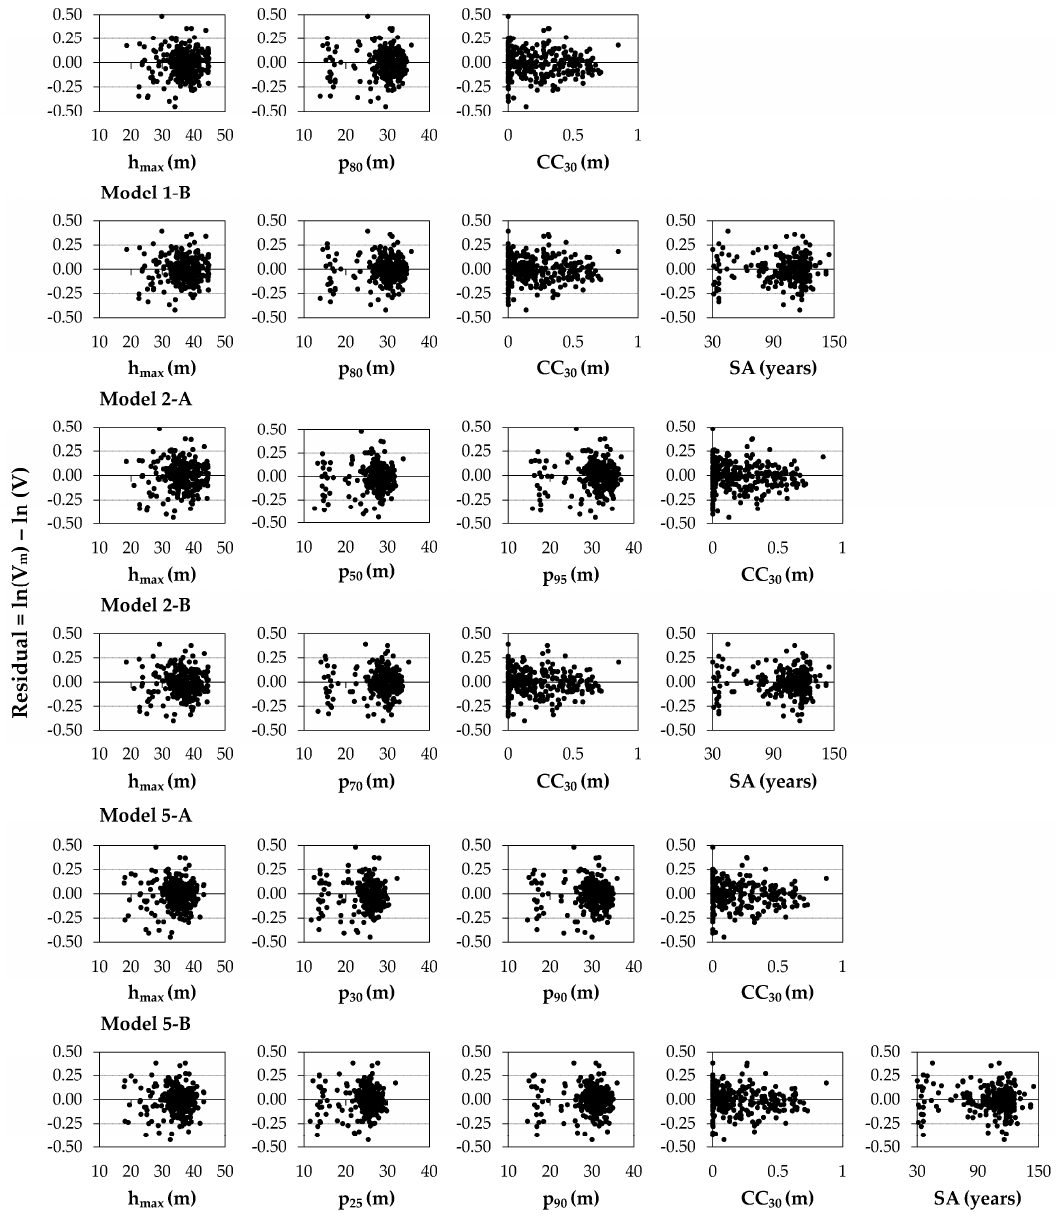
Figure A1. Residuals vs. independent variables for six selected stand-level volume models (validation dataset) described in Table A2 (V m : predicted stand volume, V: observed stand volume).